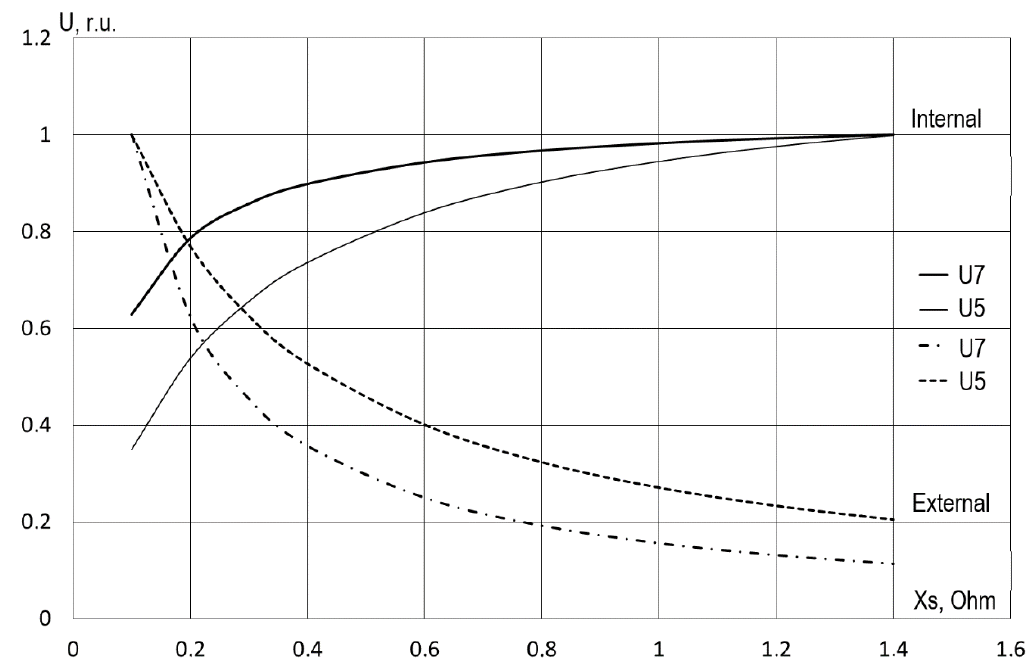
Figure 5. The dependences of the capacitor voltage at the fifth and seventh harmonics on the system impedance for the first consumer.